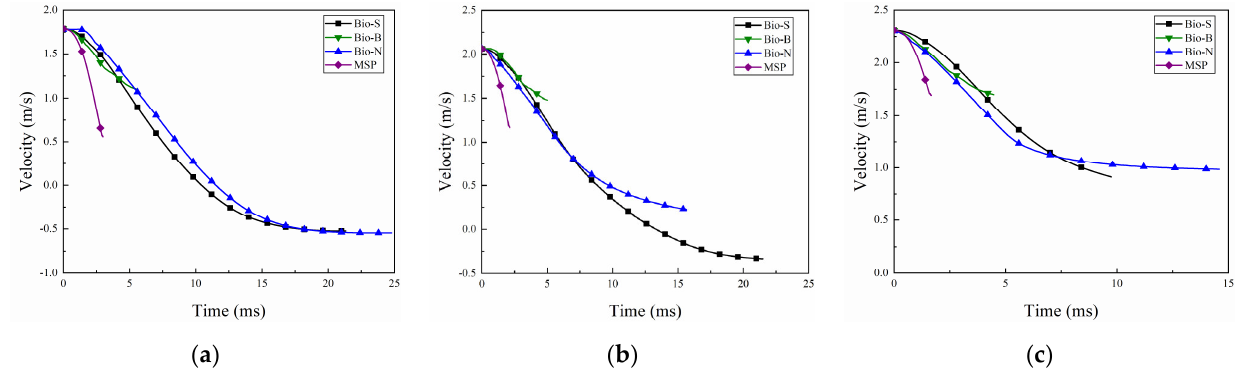
Figure 9. Velocity-time curves of bionic composite plates under different impact energy levels: ( a ) 15 J; ( b ) 20 J; ( c ) 25 J.